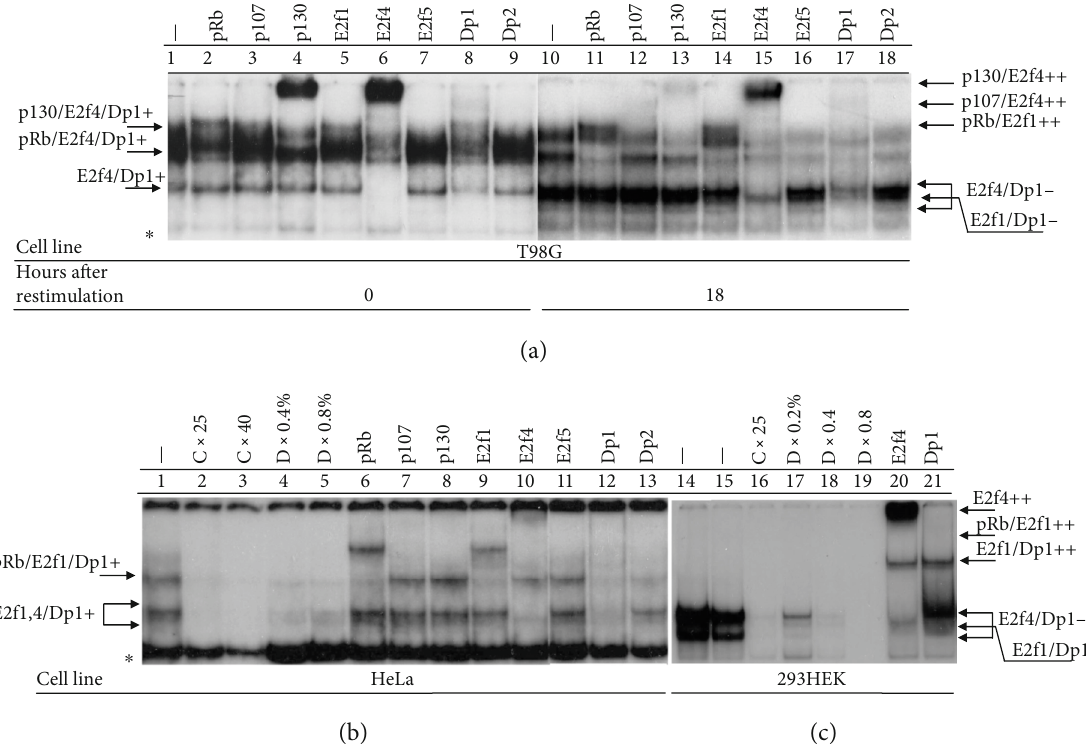
Figure 3: The analysis of the protein structure of the pocket proteins (pp)-E2f-DNA complexes in the T98G, HeLa, and the 293HEK cells by EMSA. (a) The proteins composing the pp-E2f-DNA complexes in the quiescent and cycling T98G cells. (b) The structure of the pp-E2f-DNA complexes in the cycling HeLa cells. (c) The pp-E2f-DNA complexes are completely absent in the 293HEK cells. The samples prepared from the cycling cells were treated with competitor — C, deoxycholate — D, or di ff erent antibodies as indicated. The cycling T98G, HeLa, and 293HEK cells were used, accordingly, in the 18 h and 12 h points after restimulation. The protein-DNA bands that included di ff erent proteins designated with (+), the band abolishment — (-), the supershifts induced by speci fi c antibodies — (++), and nonspeci fi c bands — ( ∗